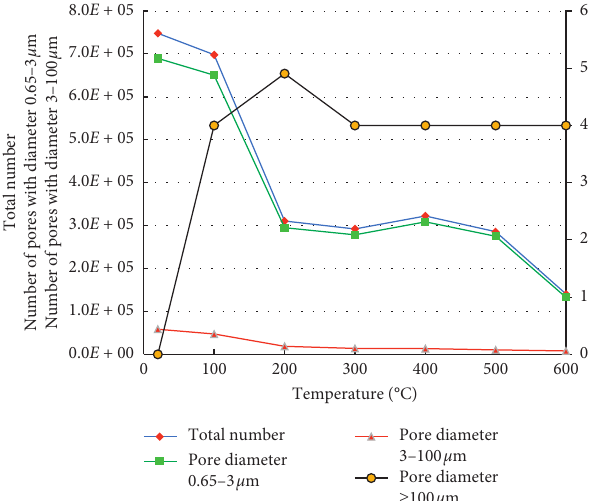
Figure 8: Variation in the number of pores with different diam- eters with the